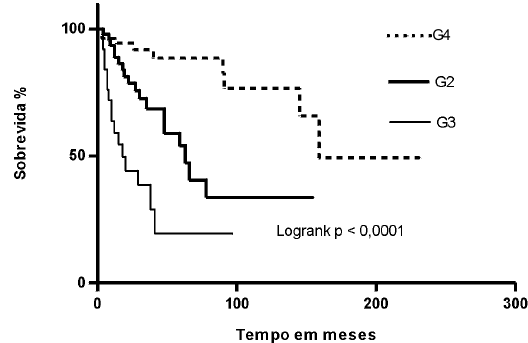
Figura 1 – Sobrevida dos pacientes versus grau do tumor.